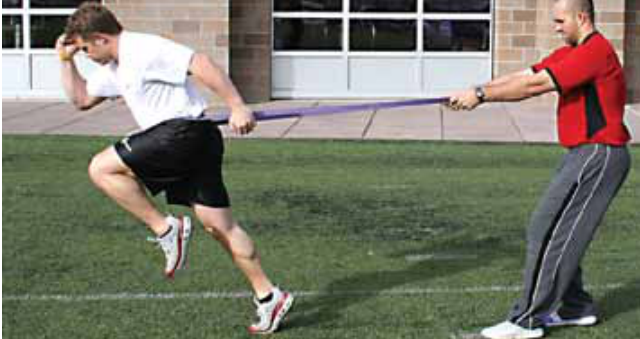
Figure 5-19. Sprinting with a